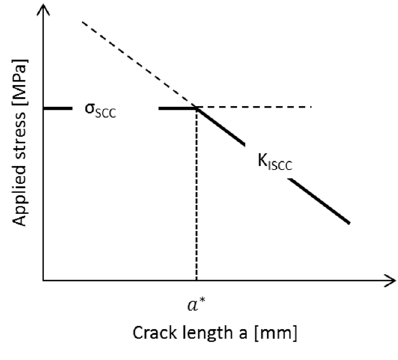
Figure 11. Definition of a * .